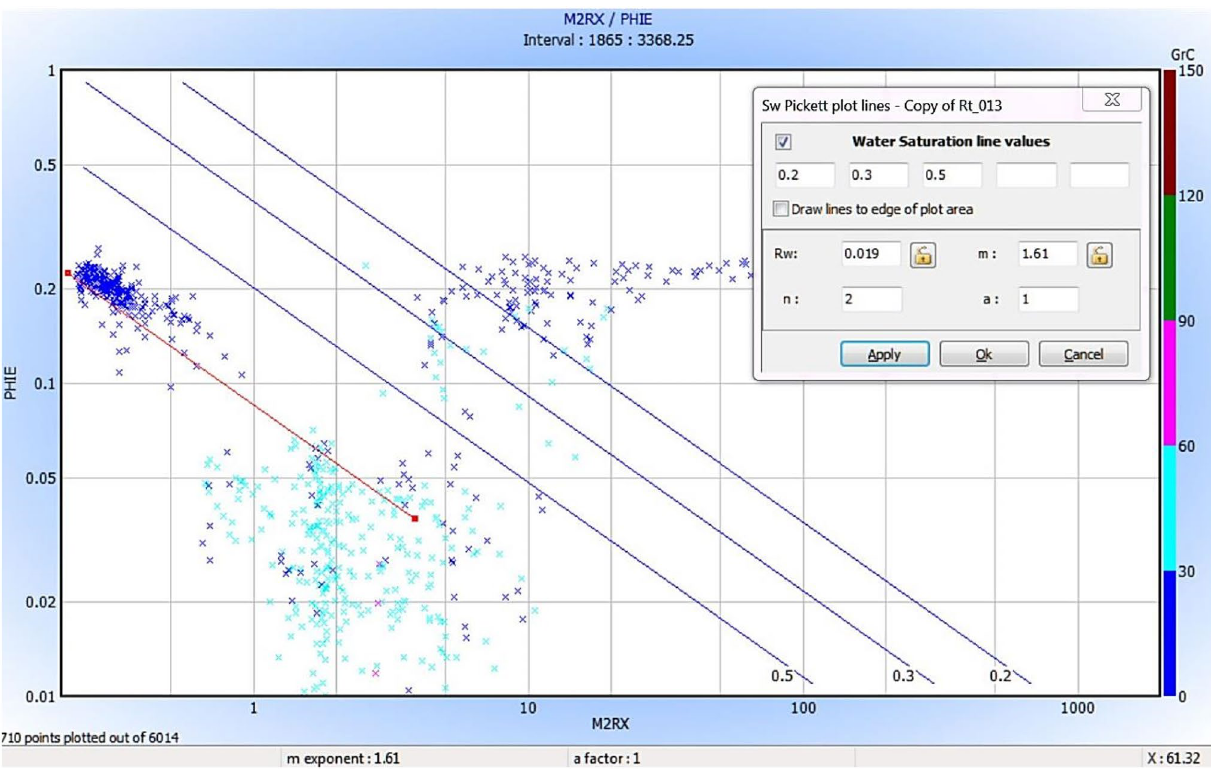
Fig. 6 Pickett plot for estimating the porosity exponent value ( m ) by knowing the formation water resistivity value (Rw), A-13 well. GR is the gamma-ray